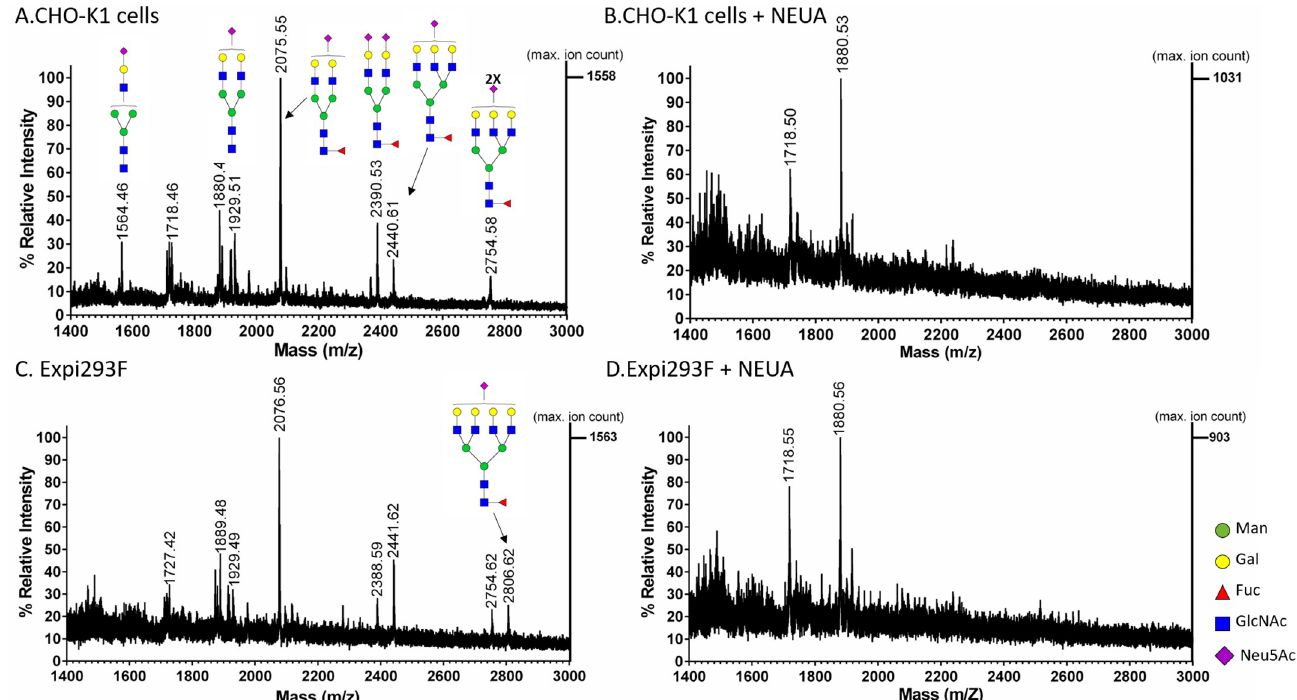
Fig 3. Negative ion MALDI-ToF analysis of acidic N -glycans released from HIV-1 gp145. The recombinant gp145 (20 μ g) produced in ( A-B ) CHO-K1 and ( C-D ) Expi293F cells were incubated overnight with ( B and D ) and without ( A and C ) Neuraminidase A (NEUA) at 37˚C. Then, gp145 proteins were resolved by SDS-PAGE and the 145 kDa bands were excised. N -glycans were released with PNGase F and were co-crystallized with 2’,4’,6’-Trihydroxyacetophenone monohydrate (THAP) ionization matrix. The x-axis represents the mass-to charge ratio (m/z) value in Daltons and the y-axis shows the relative abundance (arbitrary units) of the ions. The released glycans were analyzed using the MALDI-ToF reflector negative mode. Predicted glycan structures of the masses shown in the upper panel spectrum are the same as those shown in the spectrum on the lower panel.